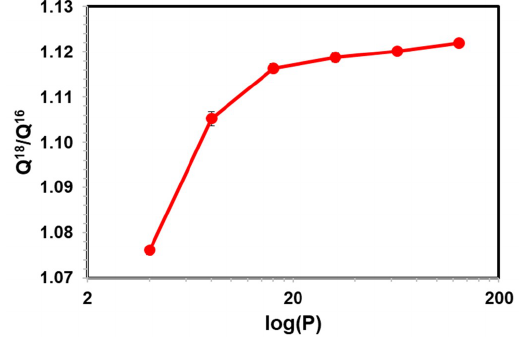
Figure 2. Computed ratio of 18 O and 16 O partition functions (Q 18 /Q 16 ) versus the number of quasi- particles P used in path integral simulations of acetaldehyde in aqueous solution. For most points, the error bars are small and hidden behind the data symbols.